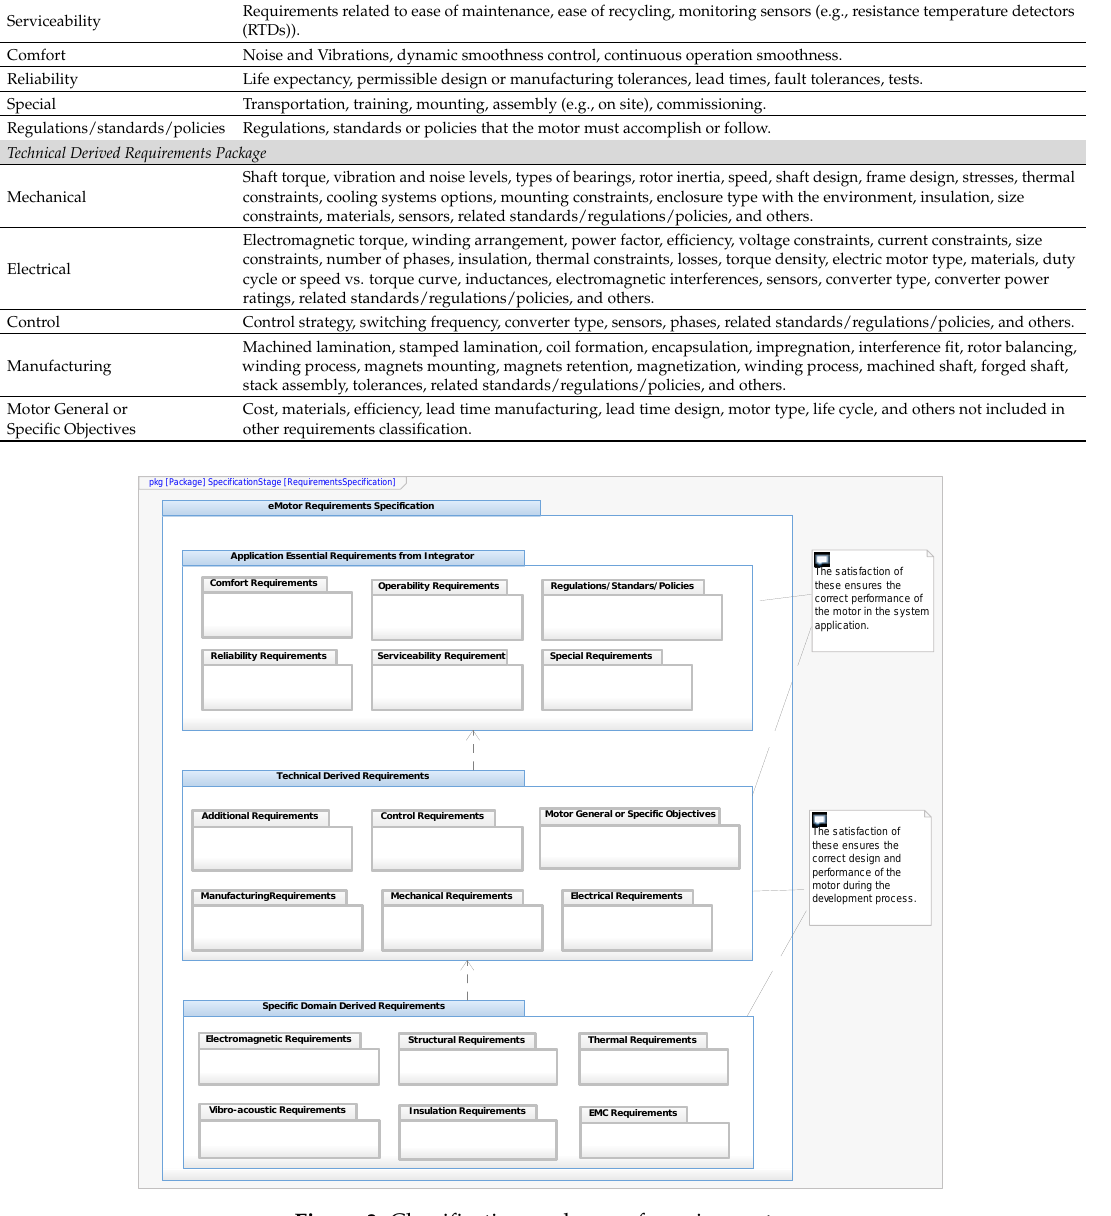
Figure 3. Classification packages of requirements. Table 1. Examples of Requirements for each Package.